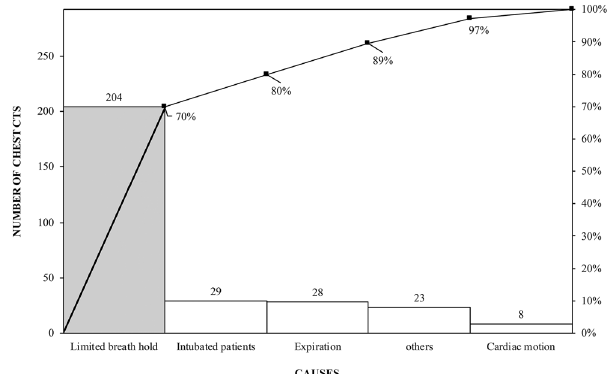
Figure 3. Diagnostic data in Pareto chart depicts the most common causes of motion impaired and expiratory phase scanning in chest